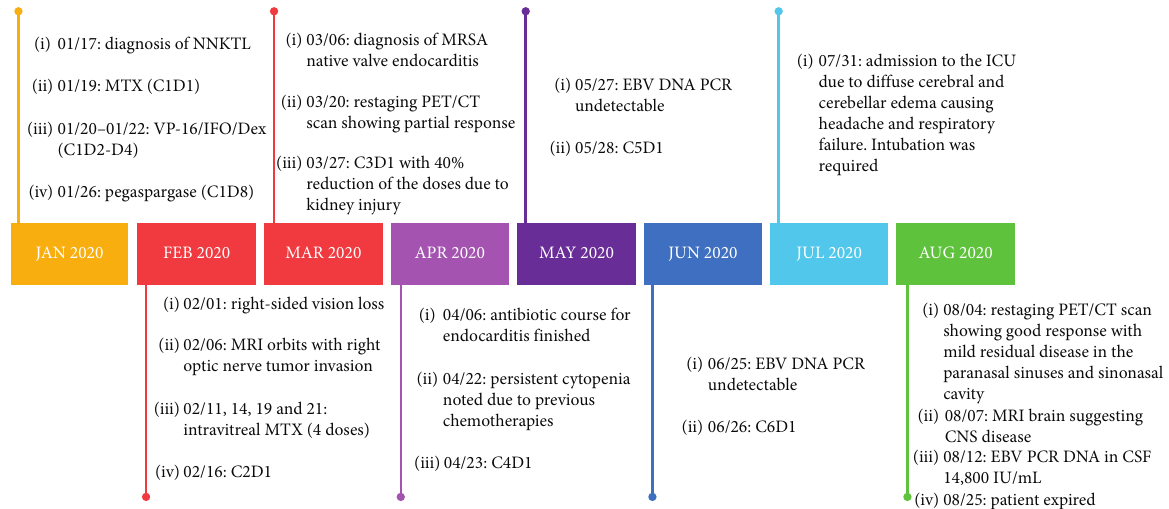
Figure 2: Timeline highlighting diagnosis, treatment schedule, disease course, and